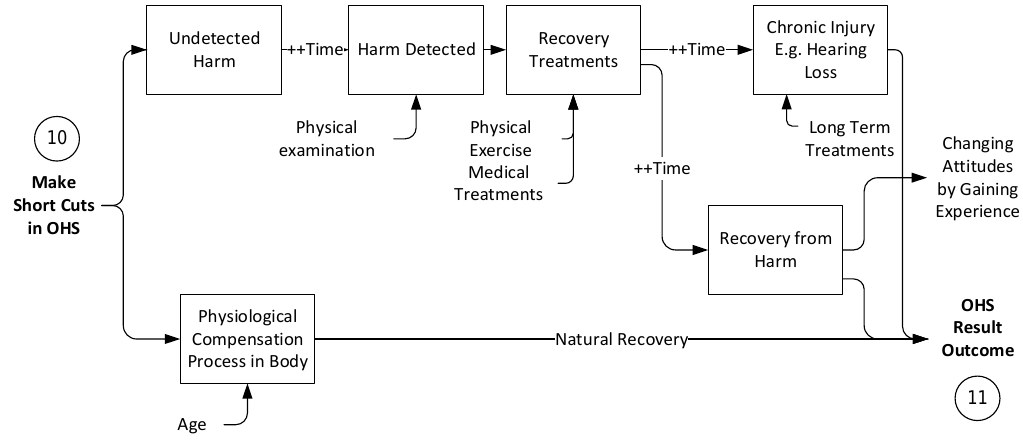
Figure 10. Occupational Health and Safety (OHS) Outcome Process Model.